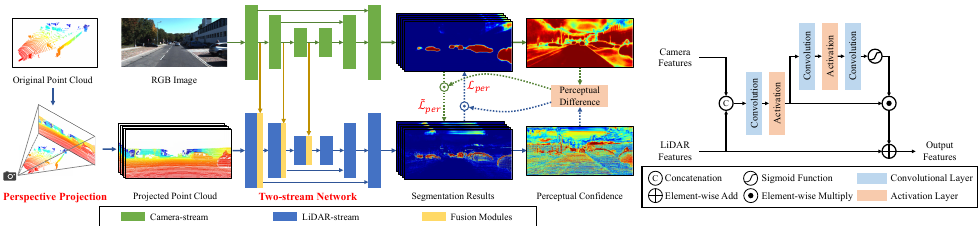
Figure 13. Figure from [107] showing the perception-aware multi-sensor fusion (PMF) architecture and fusion module. Reprinted with permission of the authors from [107]. Copyright 2021, IEEE.